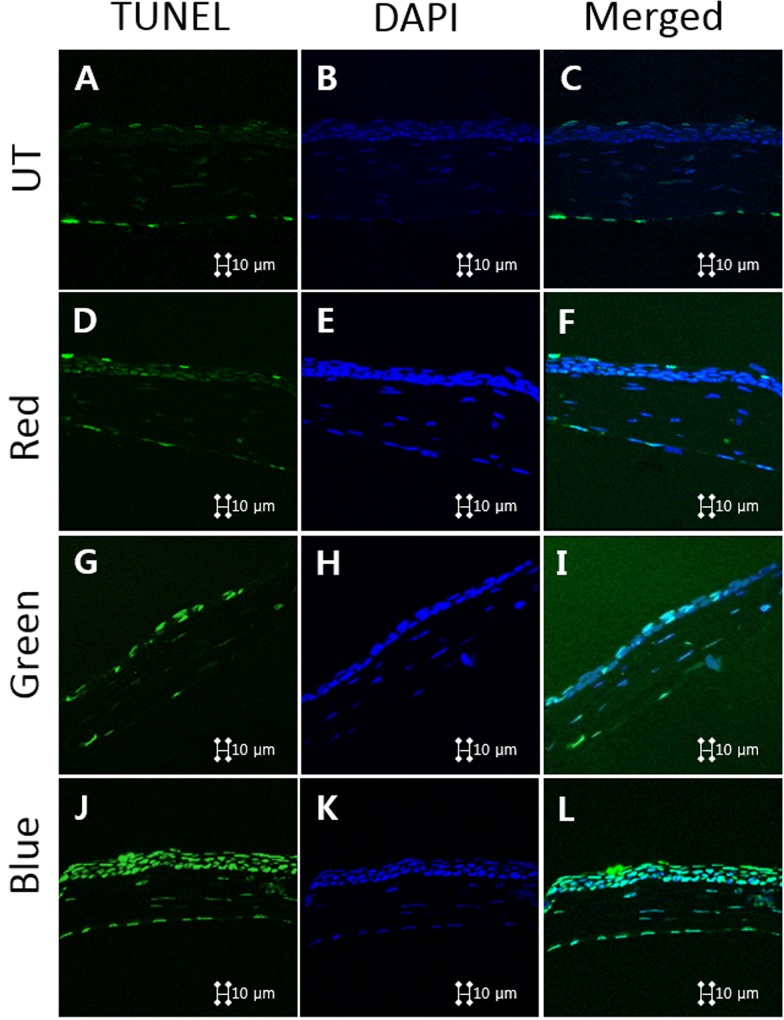
Representative images for Terminal dUTP nick-end labeling (TUNEL) assay showing the apoptotic cells in the cornea of the untouched (A, B, C), red (D, E, F), green (G, H, I), and blue (J, K, L) groups at day 10.